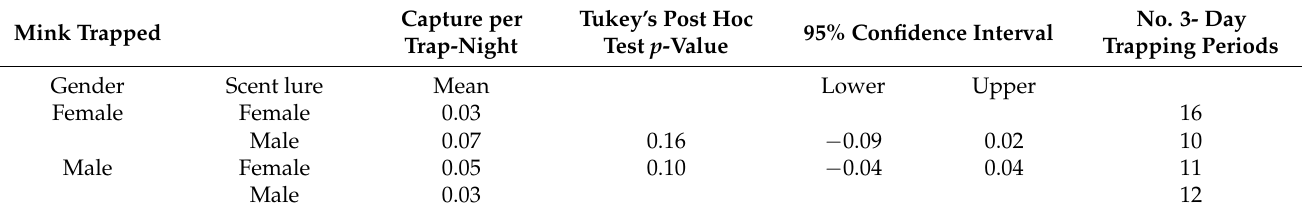
Table 3. Mean ( ± CI) male and female mink trapped per trap-night during summer associated with the gender of the scent gland